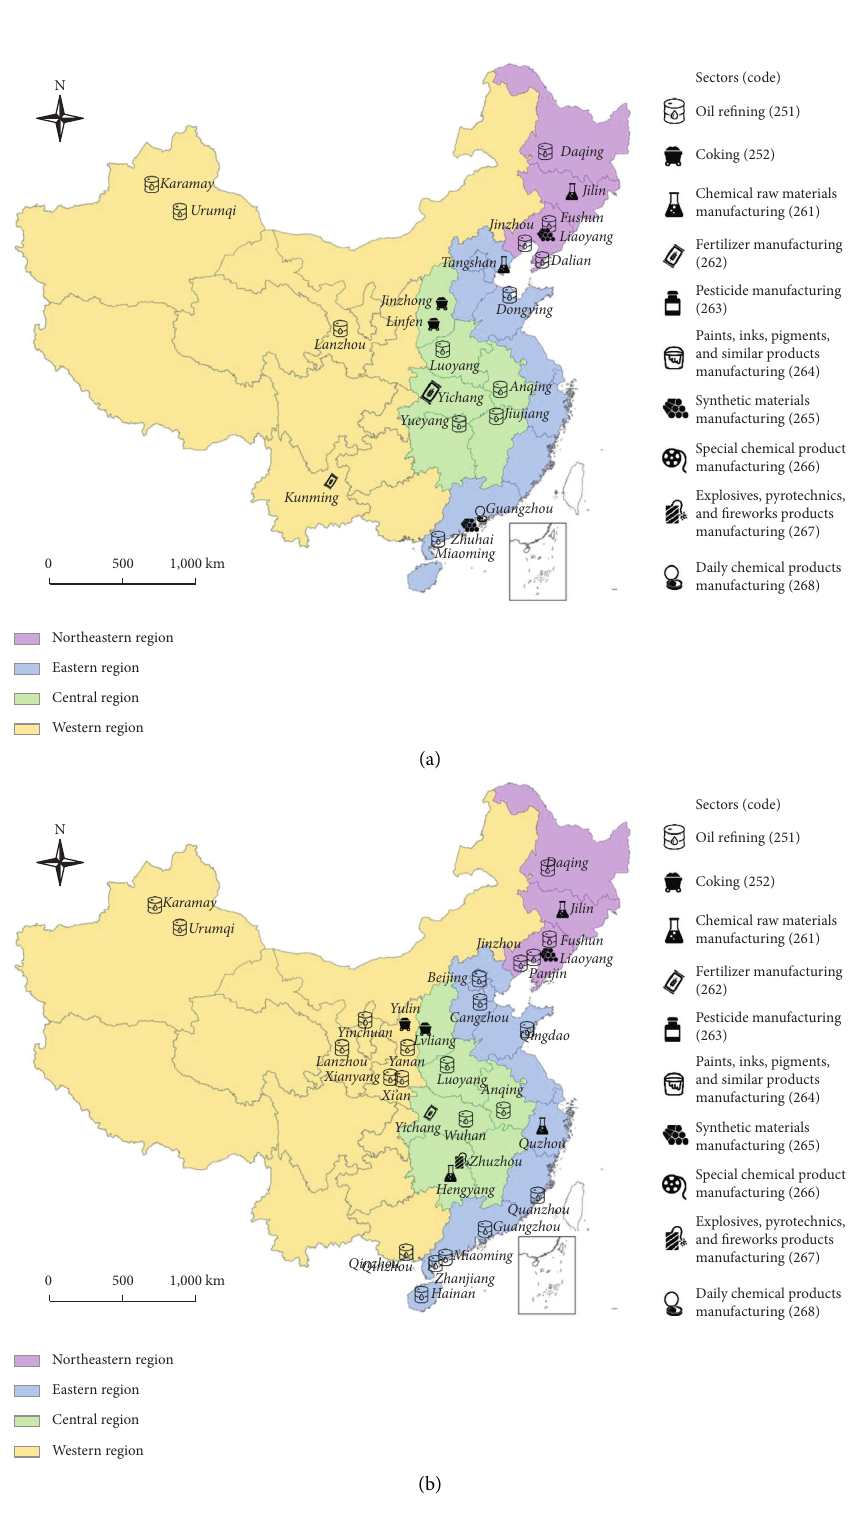
Figure 4: Spatial distribution of single-sector-led CICs in China: (a) 2003 and (b)